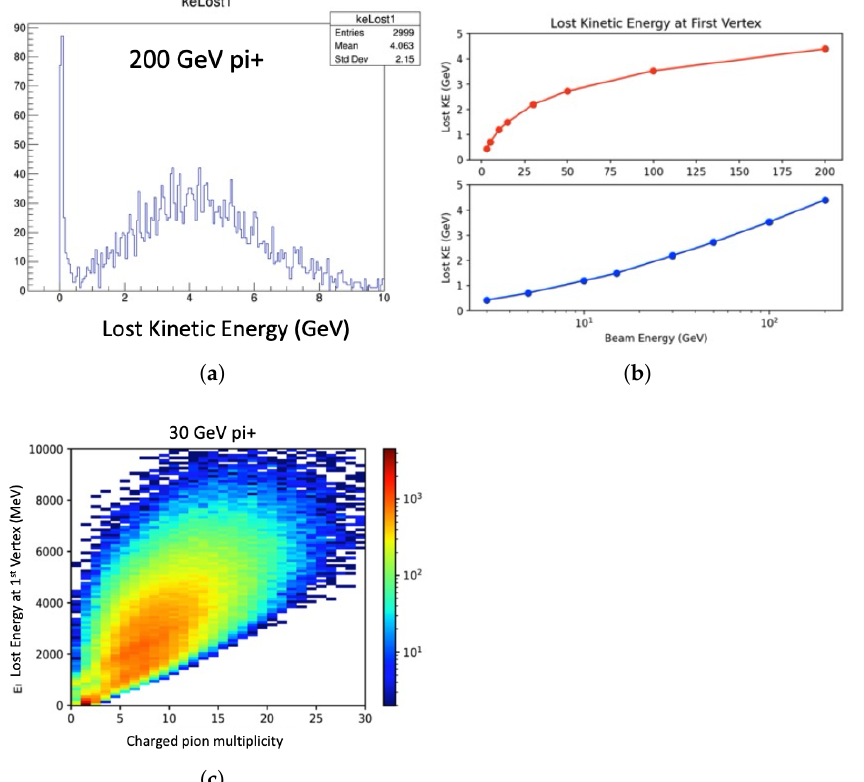
Figure 3. Loss of kinetic energy in hadron-nucleus interactions: ( a ) in the 200 GeV π + +Cu interaction, ( b ) average energy loss in π + +Cu interactions as a function of π + beam energy, shown in linear and log scales, and ( c ) correlation between the kinetic energy loss and the charged pion multiplicity in the 30 GeV π + +Cu interactions [2].